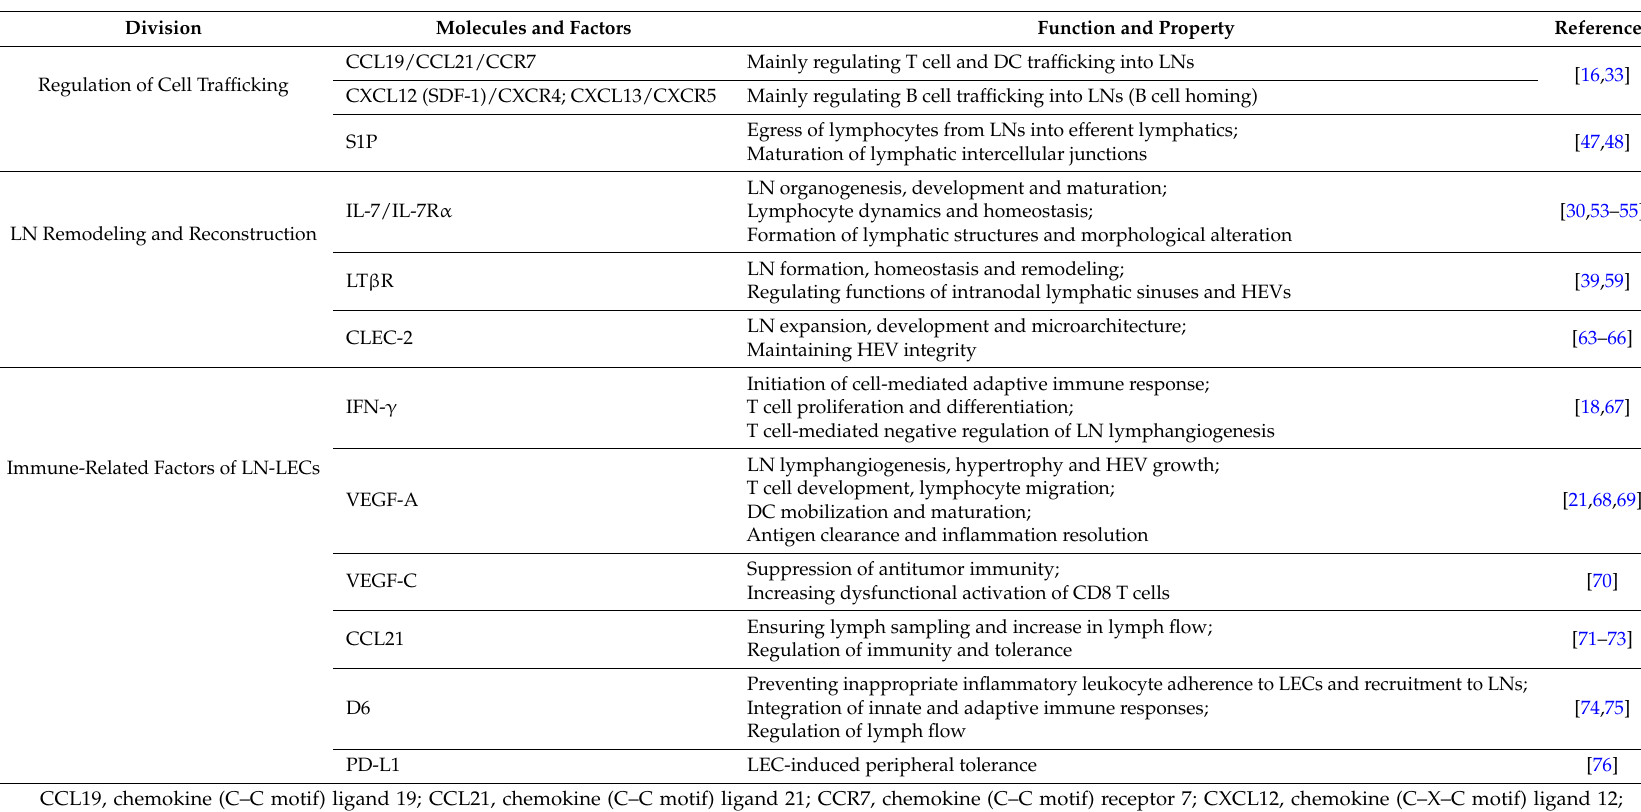
Table 1. Molecules and factors relating to the structure and immune function of lymph nodes (LNs) and intranodal lymphatic endothelial cells